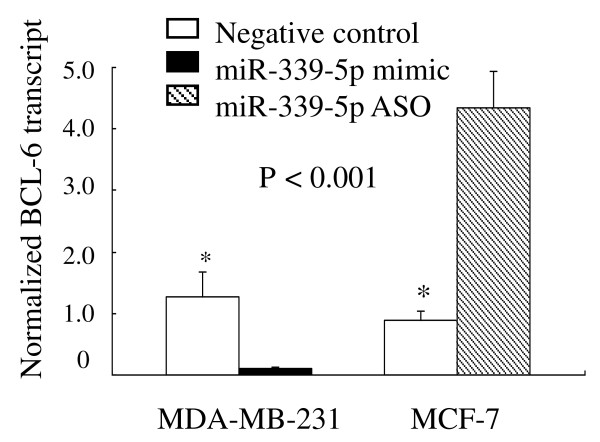
Regulation of BCL-6 mRNA expression by miR-339-5p in breast cancer cells. MDA-MB-231 and MCF-7 cells were grown and transiently transfected with miR-339-5p mimic and miR-339-5p ASO, respectively and then subjected to RNA extraction and real-time PCR analysis.